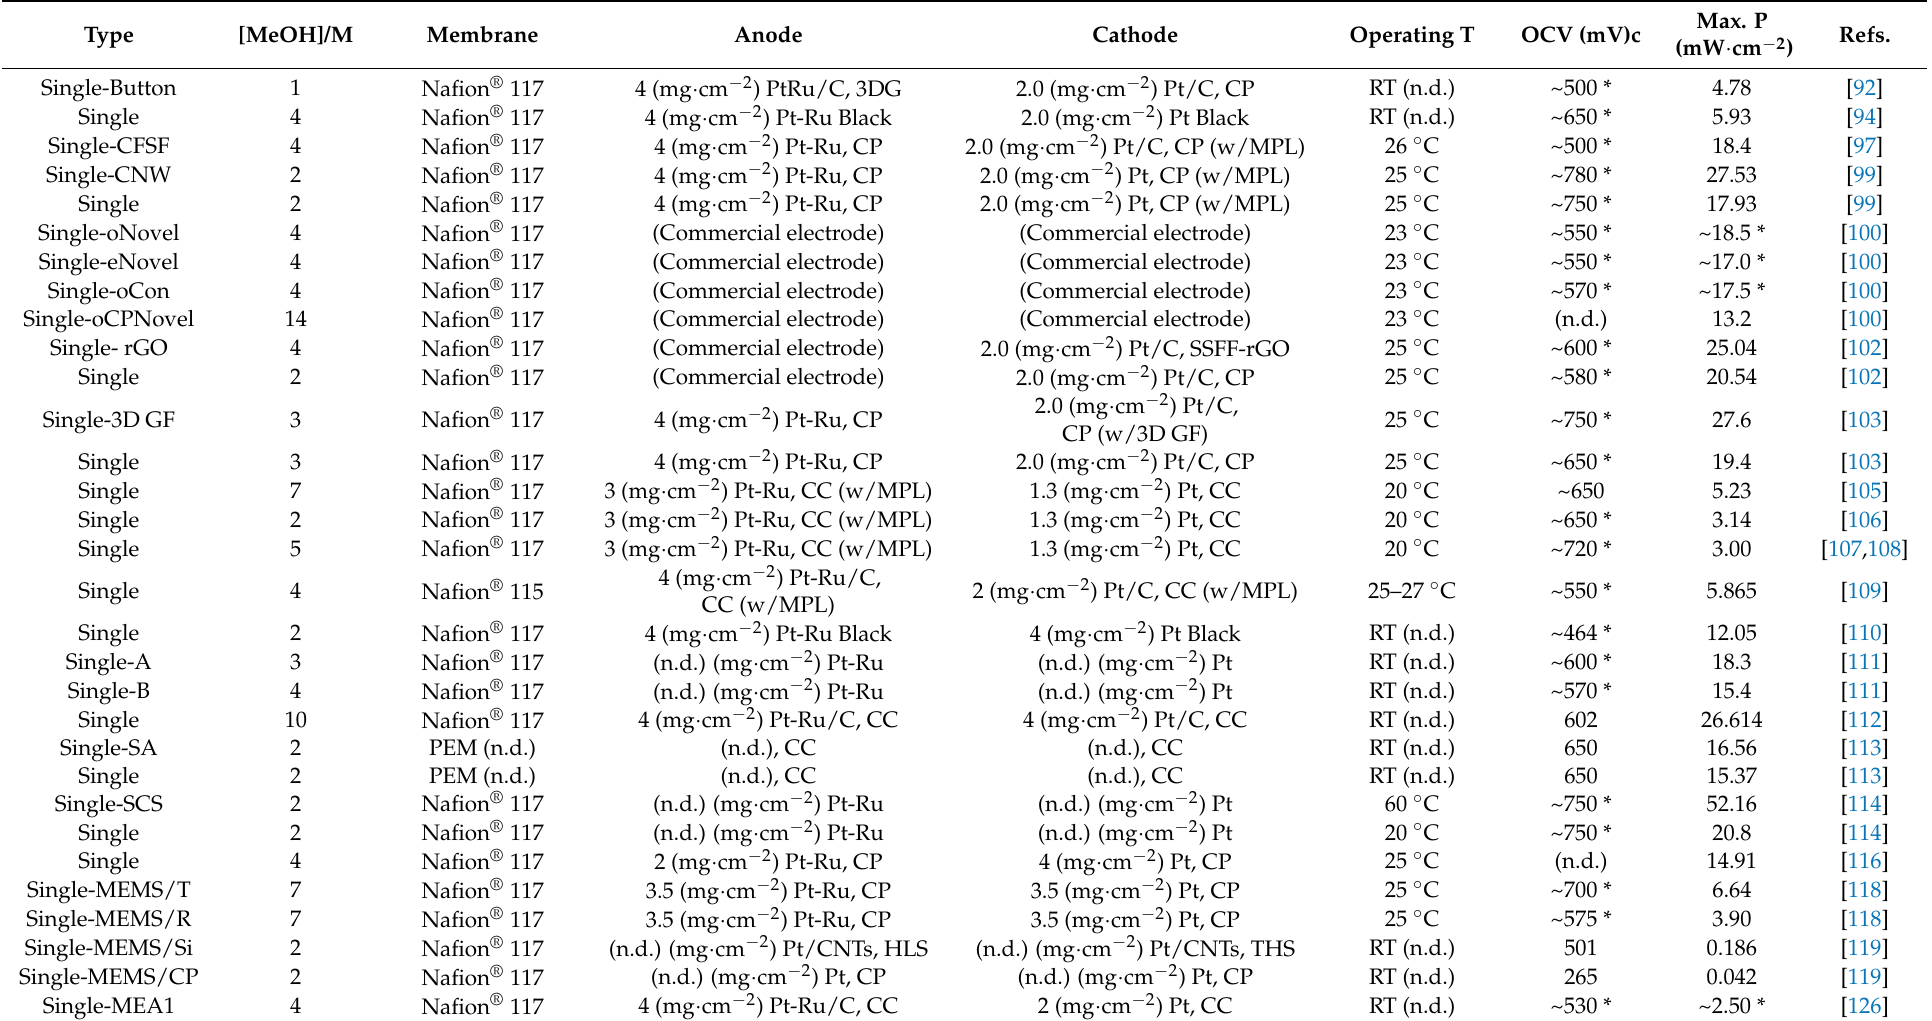
Table 2. Best performance of PS-DMFC devices (single or stack) and principal